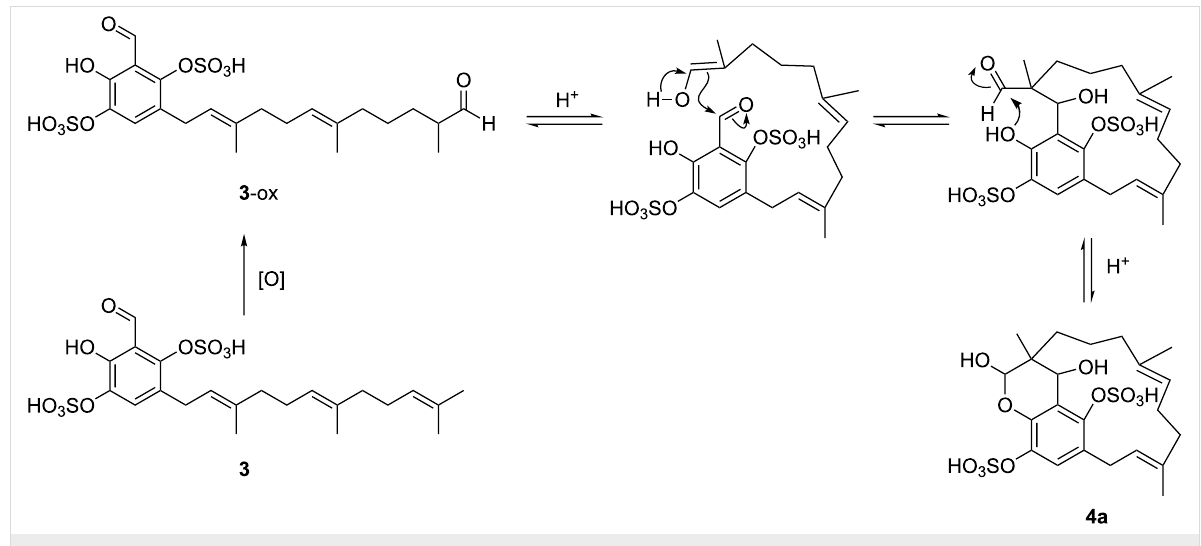
isolated from this sponge which contains a macrocycle.